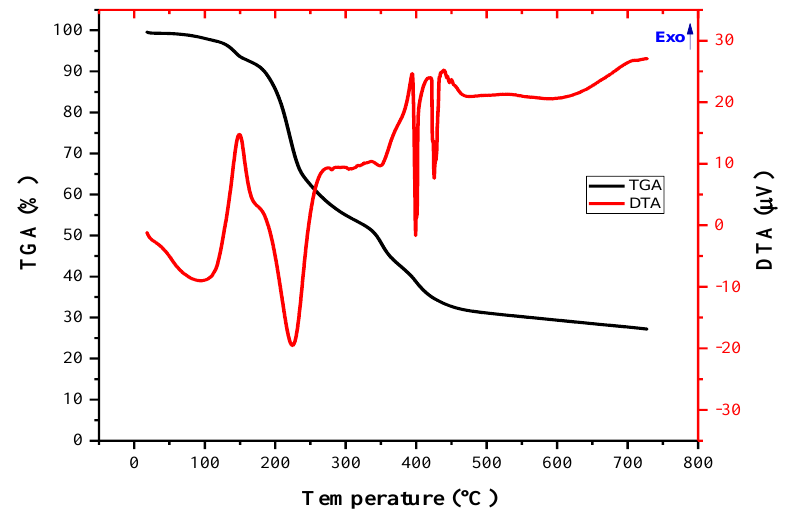
Figure 7. TGA/DTA curve pf the as-prepared ZnO.